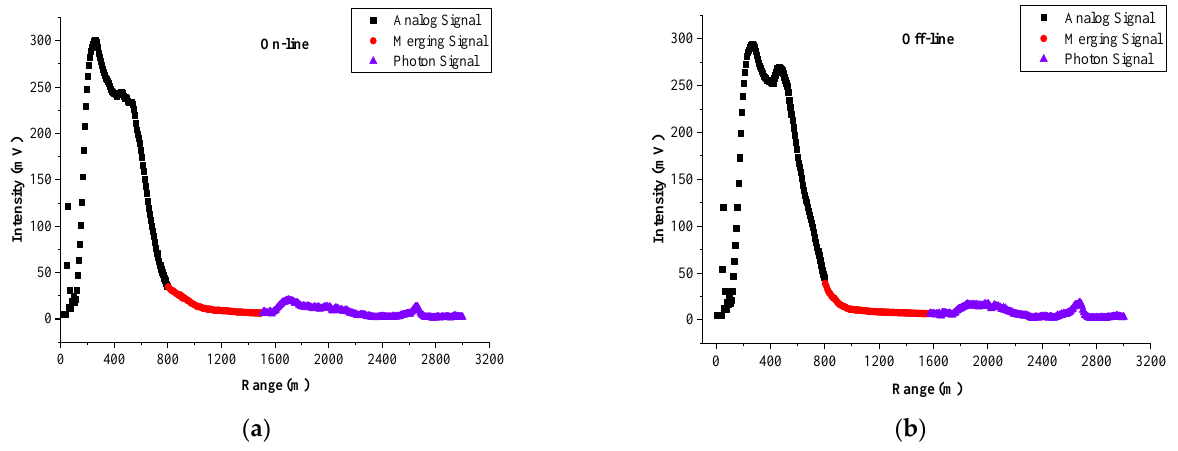
Figure 10. Piecewise splicing effect of AD and PC signals, ( a , b ) are online wavelength and offline wavelength, respectively.